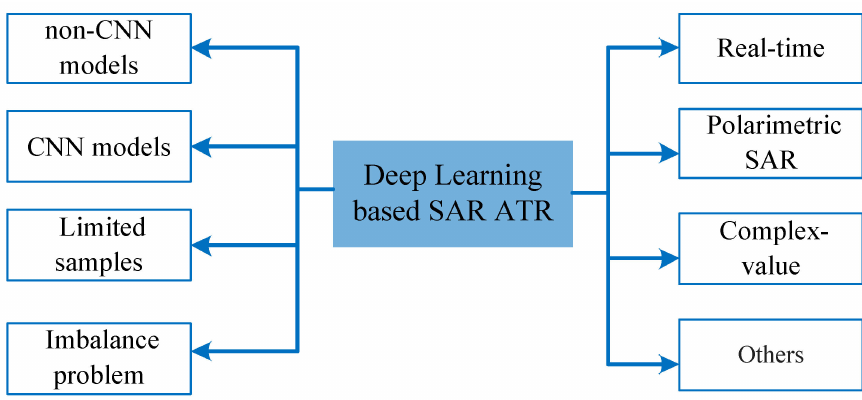
Figure 8. The deep-learning-based